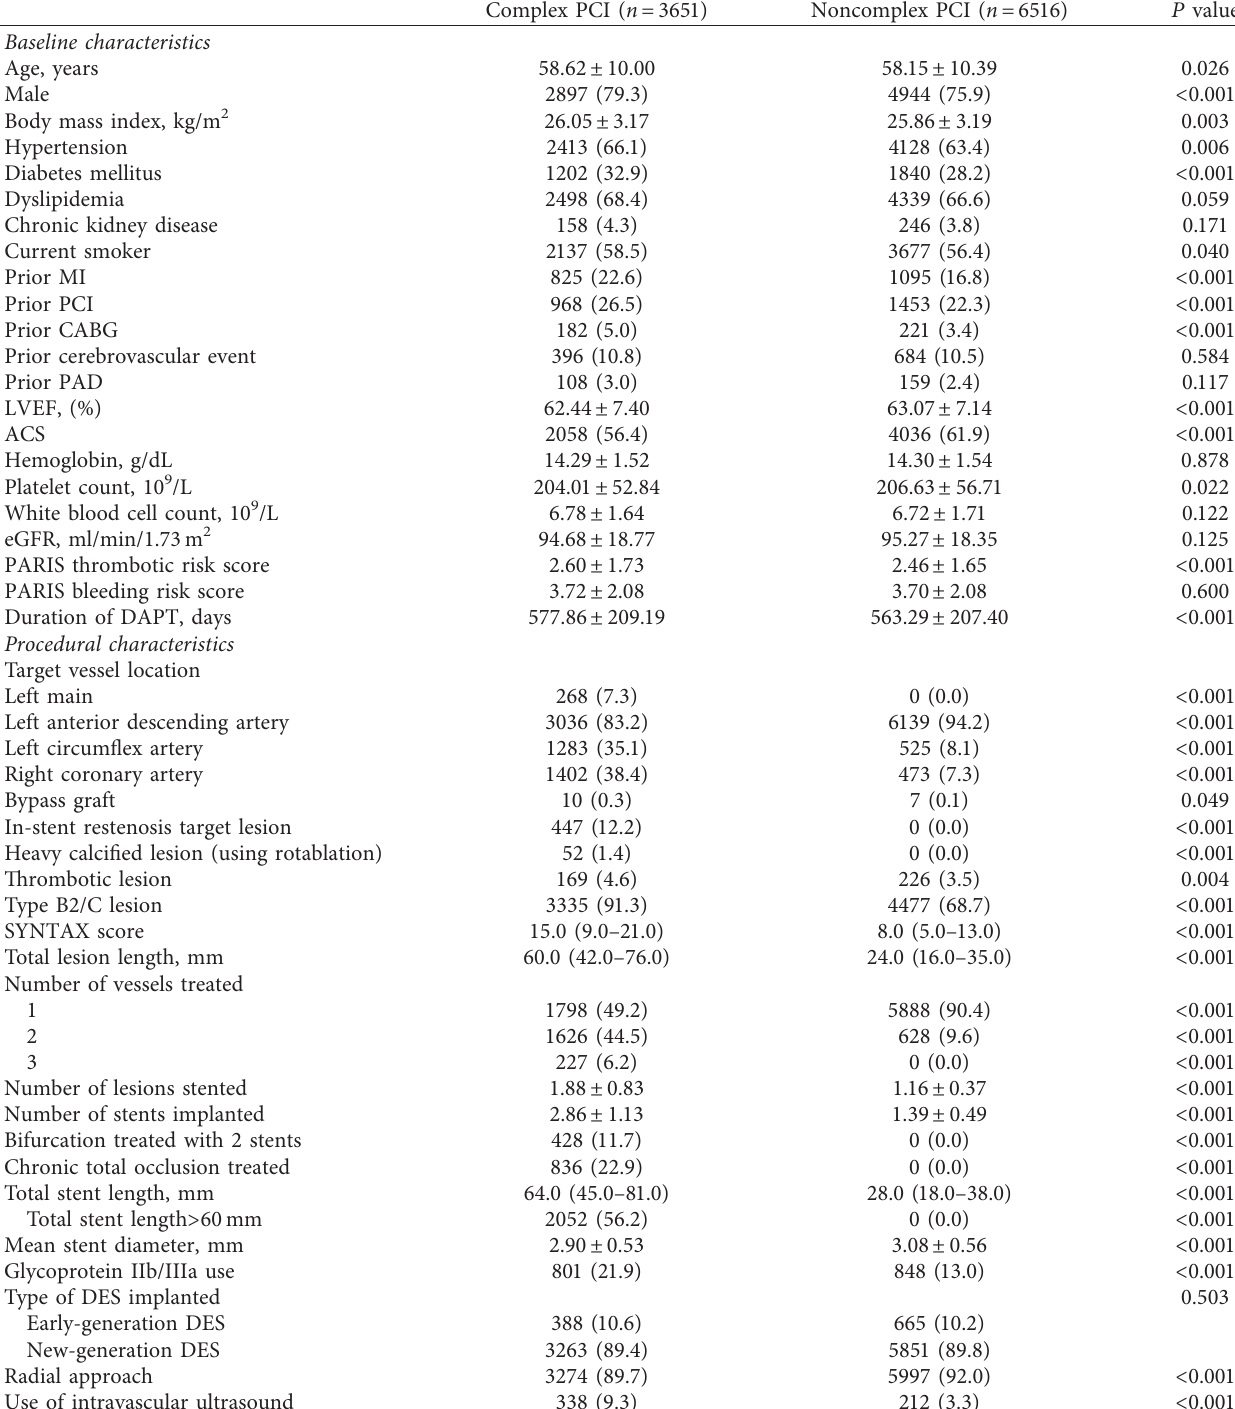
Values are mean ± SD or median (interquartile range) for continuous variables, and n (%) for categorical variables. ACS � acute coronary syndrome (s); CAD � coronary artery disease; CABG � coronary artery bypass grafting; DAPT � dual antiplatelet therapy; DES � drug-eluting stents; EF � ejection fraction; LVEF � left ventricular ejection fraction; MI � myocardial infarction; NSTEMI � non-ST-segment elevation myocardial infarction; PAD � peripheral artery disease; PCI � percutaneous coronary intervention; PARIS � Patterns of Nonadherence to Antiplatelet Regimen in Stented Patients; STEMI � ST-segment elevation myocardial